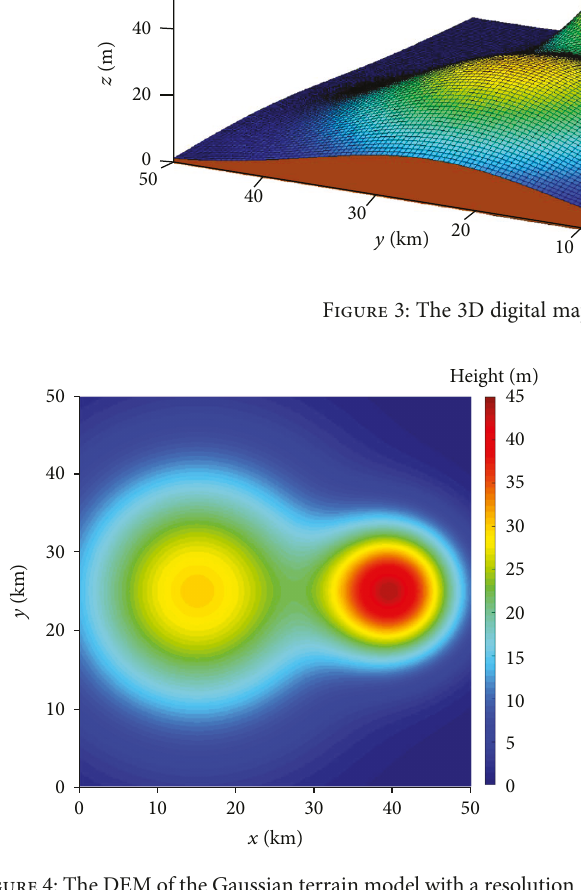
Figure 4: The DEM of the Gaussian terrain model with a resolution of 100